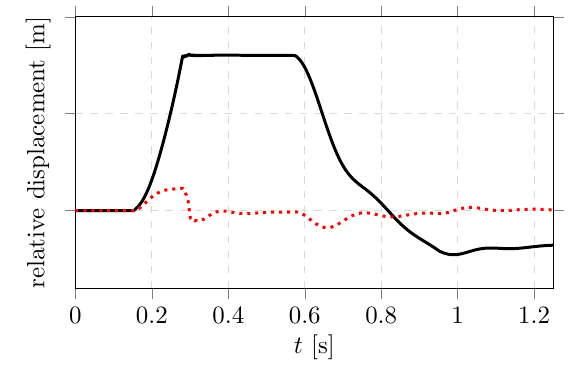
Figure 13: Displacement ( x black curve, y red curve) of rotor shaft relative to the stator at the location of the landing bearing modelled in BEAST.